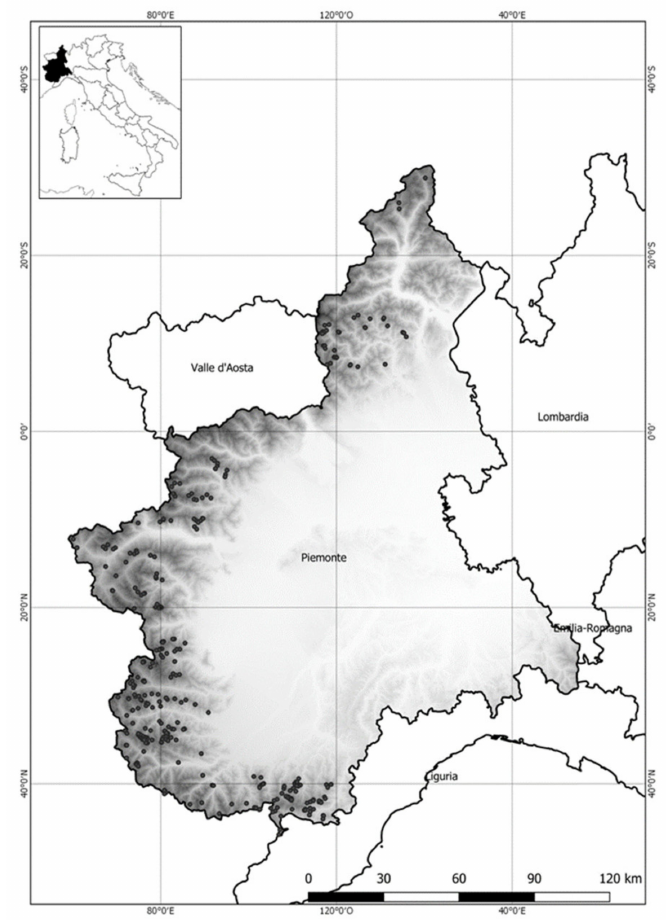
Figure 1. Location of the 324 survey sites in north-western Italian Alps. Each black dot represents a